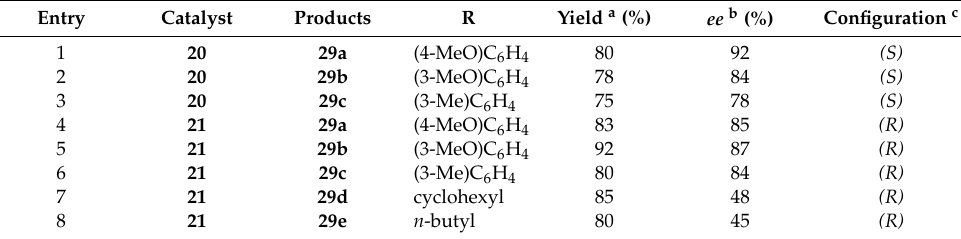
Table 3. Addition of diethylzinc to aldehydes, catalyzed by 10 mol % 20 or 21.